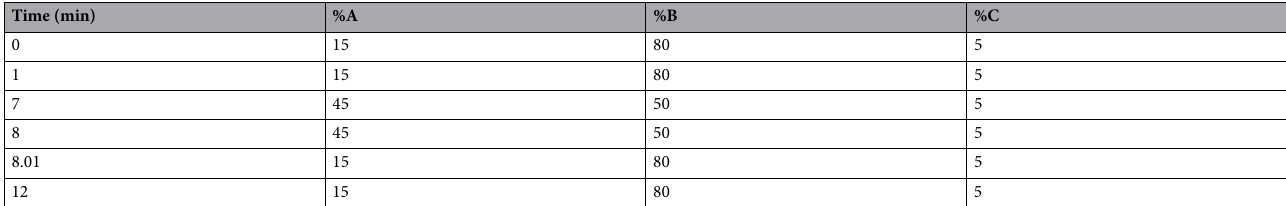
Table 2. Chromatographic gradient for HCD